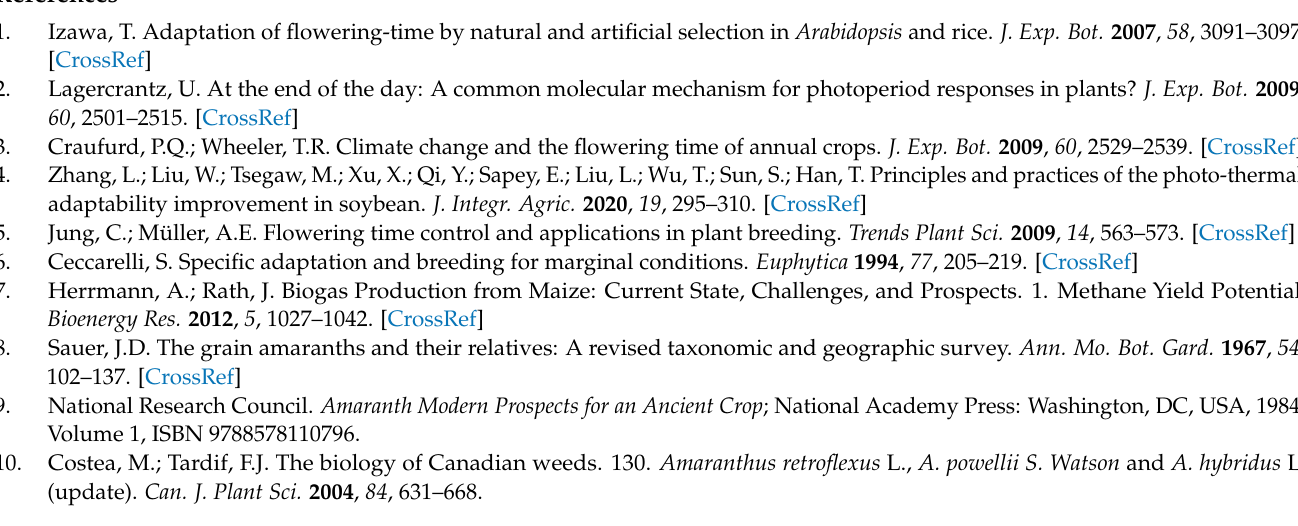
Figure S3: Box plots of three phenotypic traits and six environmental variables among the Central American accessions that were grouped by seed setting ‘1’ or no seed setting ‘0’. In each box plot the two groups were compared using a least significant difference (LSD) test and the groups with different letters are significantly different at alpha = 0.05. No letters if there is no significant difference among the two groups. Black asterisks indicate the mean values of each group in the box plots; Figure S4: Box plots of three phenotypic traits and six environmental variables among the Central American A. hypochondriacus accessions that were grouped by seed setting ‘1’ or no seed setting ‘0’. In each box plot the two groups were compared using a least significant difference (LSD) test and the groups with different letters are significantly different at alpha = 0.05. No letters if there is no significant difference among the two groups. Black asterisks indicate the mean values of each group in the box plots; Table S1: List of the accessions; Table S2: Accessions that did not flower; Table S3: Photoperiod-insensitive accessions that are of non-Central American origin but set seed; Table S4: Mild photoperiod-sensitive accessions that are of non-Central American origin but set seed; File S1: Statistical Analyses of Amaranth Characterization